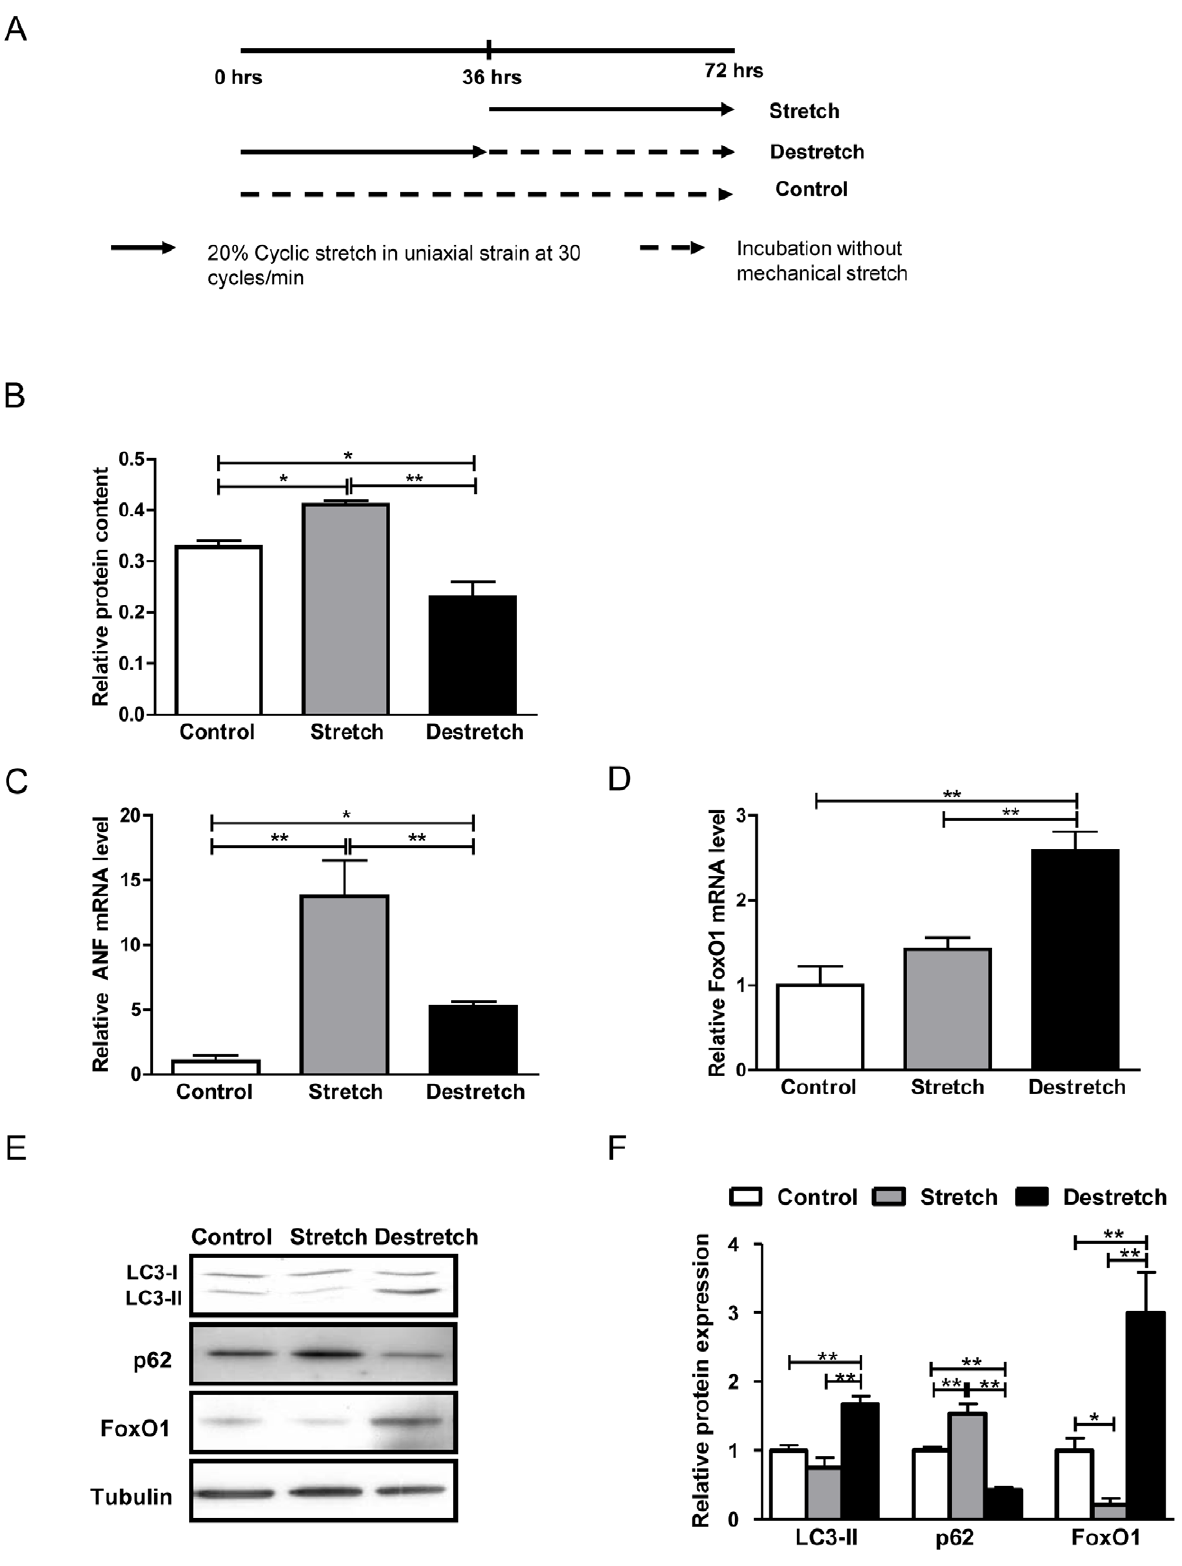
Figure 5. FoxO1 expression and autophagy are increased in an invitro model of regression of cardiac hypertrophy. Cardiomyocytes were cultured in BioFlex plates, subjected to mechanical cyclic stretch for 36 hours (Stretch) and incubated without stretch for 36 hours (de-stretch). A) Scheme showing the regimen of mechanical stretch and de-stretch. B) Relative protein content. C–D) mRNA levels of ANF and FoxO1, determined by qRT-PCR. E) Representative immunoblots. F) Densitometric analyses. Data represent means from at least 4 different myocyte cultures. * p , 0.05, ** p , 0.01. doi:10.1371/journal.pone.0051632.g005 PLOS ONE |